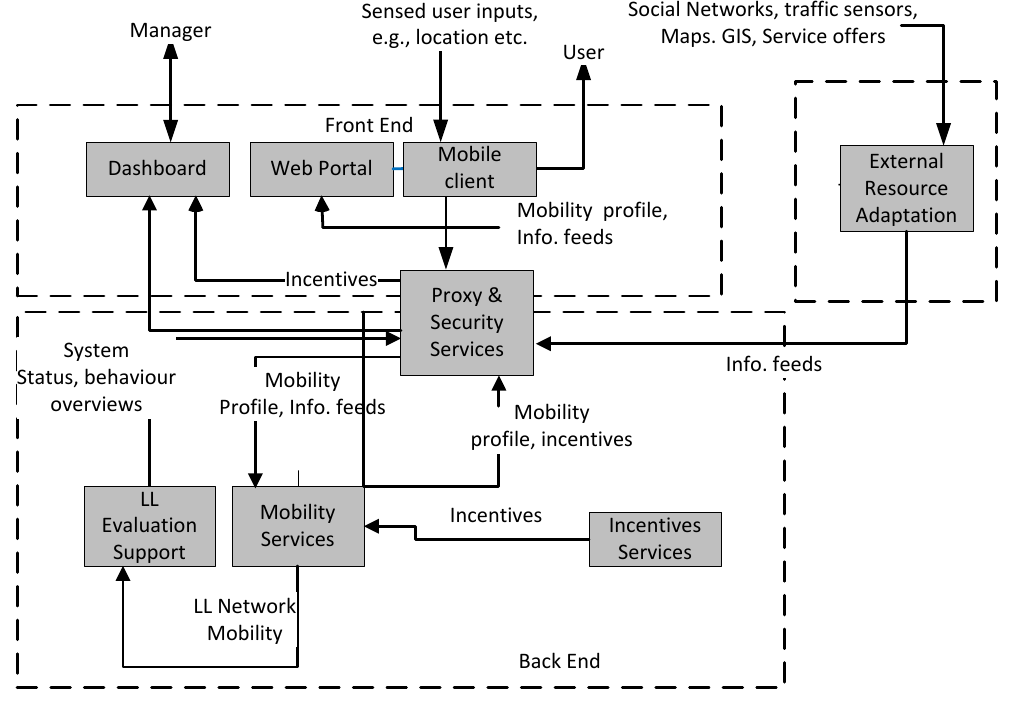
Figure 1. High-level architecture for the tripzoom